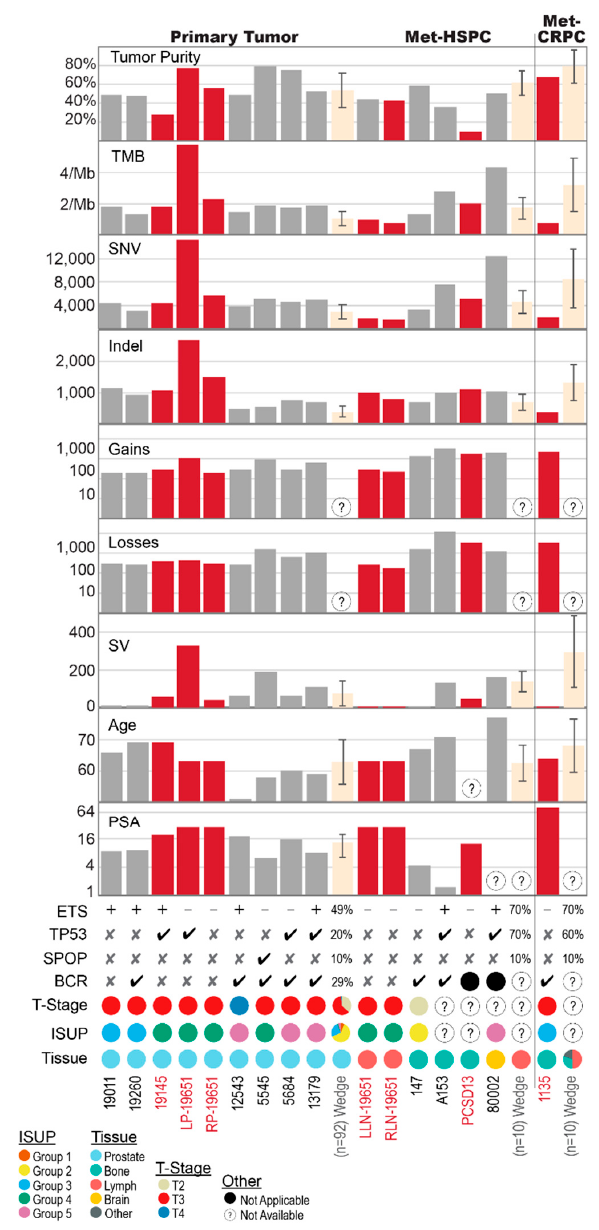
Figure 1. Summary of genomic landscape relevant to tumour purity and related to clinical and pathological features for 16 samples from 13 patients, and further compared to the Wedge et al. data. Met-HSPC: metastatic hormone sensitive PCa; met-CRPC: metastatic castration-resistant PCa; TMB: Tumour mutational burden; SNV: single nucleotide variants; Indel: small insertion or deletion; Gains and Losses: somatic copy number alterations (SCNA); SV: Structural variation including large insertions or deletions, inversions, translocations and duplications; PSA: prostate-specific antigen (ug / L); ETS: presence of ETS fusion event; TP53: presence of TP53 alteration including SNV, SCNA or SV; SPOP: presence of SPOP SNV; BCR: biochemical recurrence; ISUP: International Society of Urological Pathologists cancer grade (correlates to Gleason scores). Error bars for Wedge et al. data reflect +/ − one standard deviation of the sub-group totals. Sample identifiers in red, with matching red bar plots, are indicative of patients pre-treated with